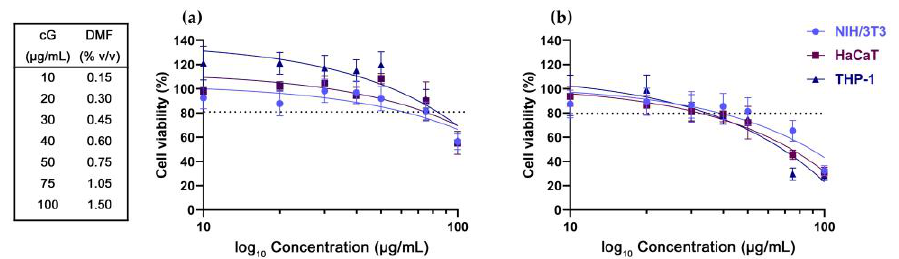
Figure 1. Cell viability of NIH/ 3T3, HaCaT and THP-1 cells after treatment with DMF for 24 ( a ) and 48 h ( b ). The corresponding concentrations (% v / v ) of the solvent DMF with cG’s doses are being depicted in the table on the left.